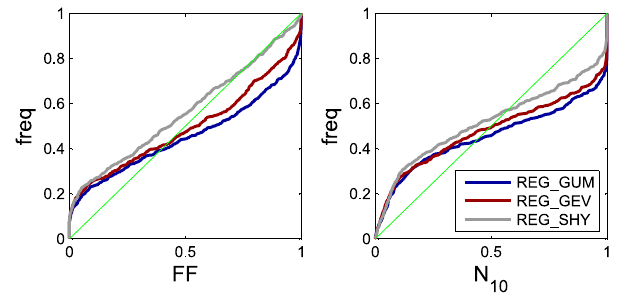
Fig. 4. Reliability indices for regional